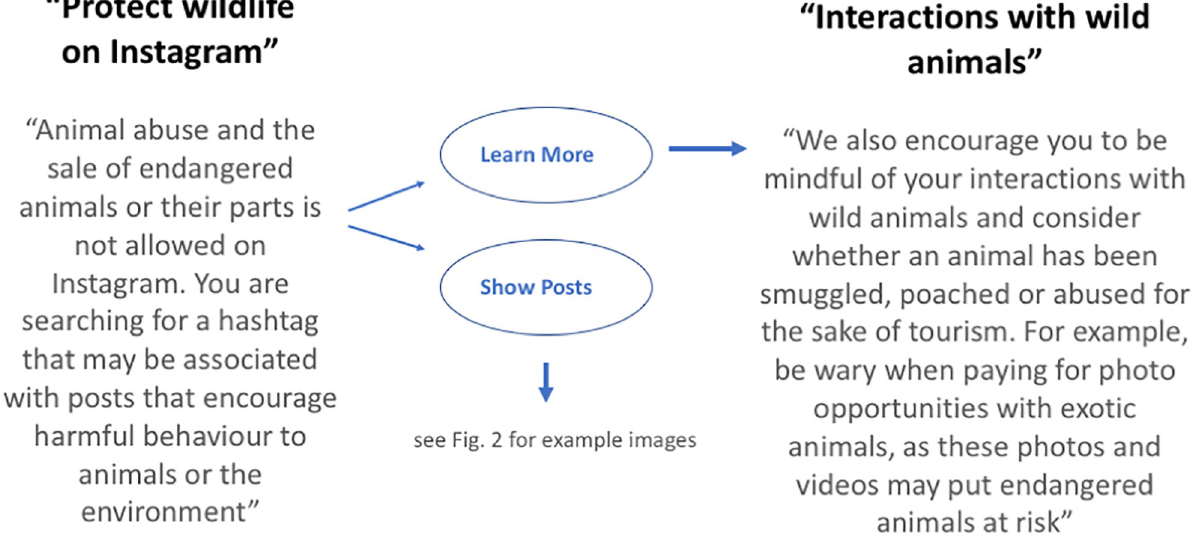
Fig 1. Instagram’s wildlife selfie pop-up alert system showing the warning presented when users search for wild animal selfie hashtags (e.g. #elephantselfie) (left), the follow-on options given (middle), and an extract from the information provided (right) when users select ‘Learn More’.